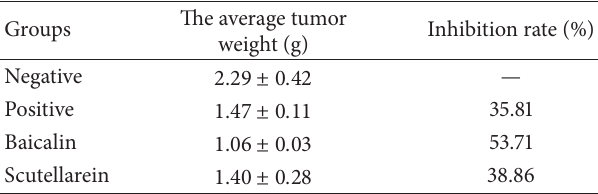
Table 1: The effect of baicalin and baicalein inhibition rate of U14 cervical cancer in mice.